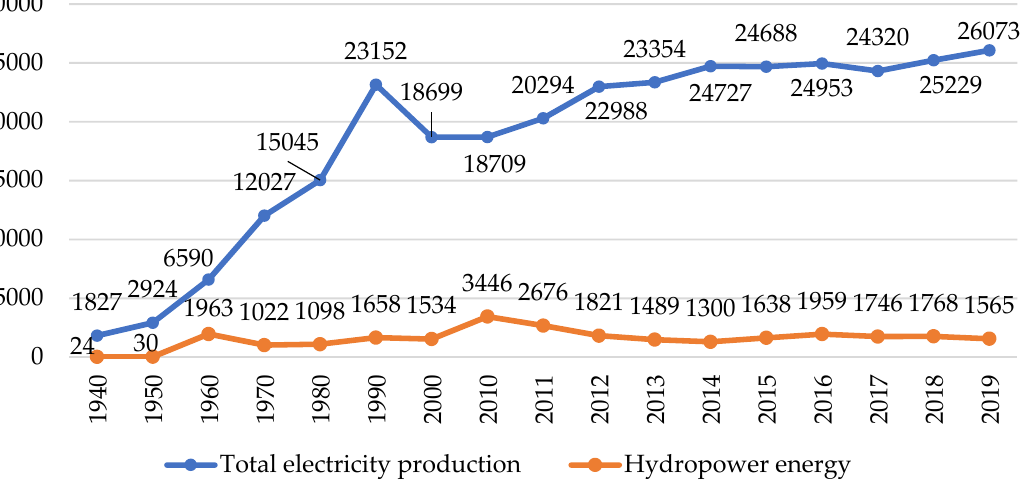
Figure 4. Total electricity production and share of hydropower energy (million kWh, 1940–2009) [22].